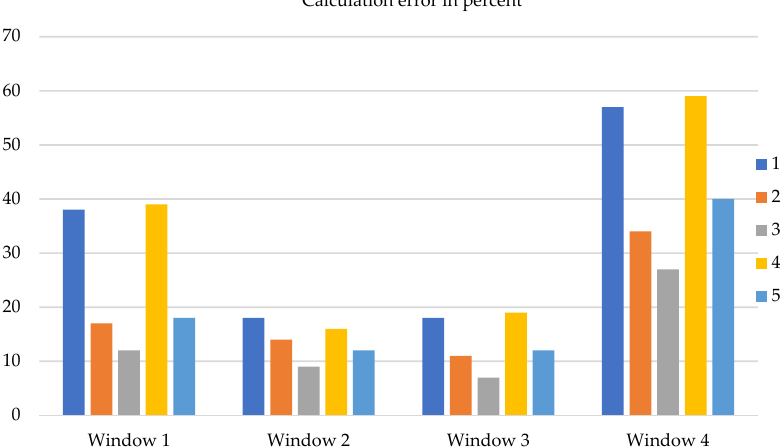
Figure 12. Distribution of the local values of heat flux density on the window surface: 1—upper left corner of the window; 2—lower left corner of the window; 3—in the center of the window; 4—upper right corner of the window; 5—lower right corner of window; windows: 1—standard triple-pane; 2—triple-pane filled with argon; 3—triple-pane with an interactive cover; 4—triple-pane with a heated base; The comparison of the results concerned the calculated data obtained using a standard mathematical model [90] with our experimental data. The heat flux density for different types of windows of the same height was: − for a triple-pane window filled with air: 1.29 W/m 2 , 1.72 W/m 2 , and 1.86 W/m 2 ; − for a triple-pane window filled with argon: 1.1 W/m 2 , 1.2 W/m 2 , and 1.65 W/m 2 ; and −